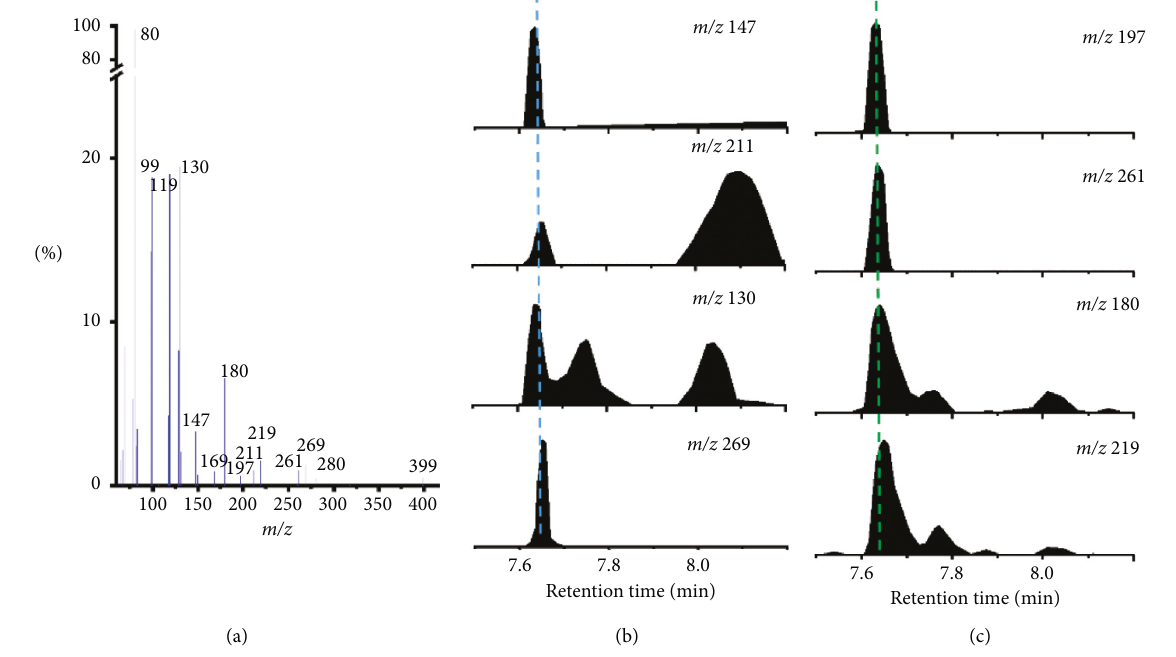
Figure 3: Mass spectra of chromatographic peak A3 (a) presented in Figure 1; Chromatographs of typical fragment ions of peak A3 (B and C), reflecting the compositions of two PFHxS